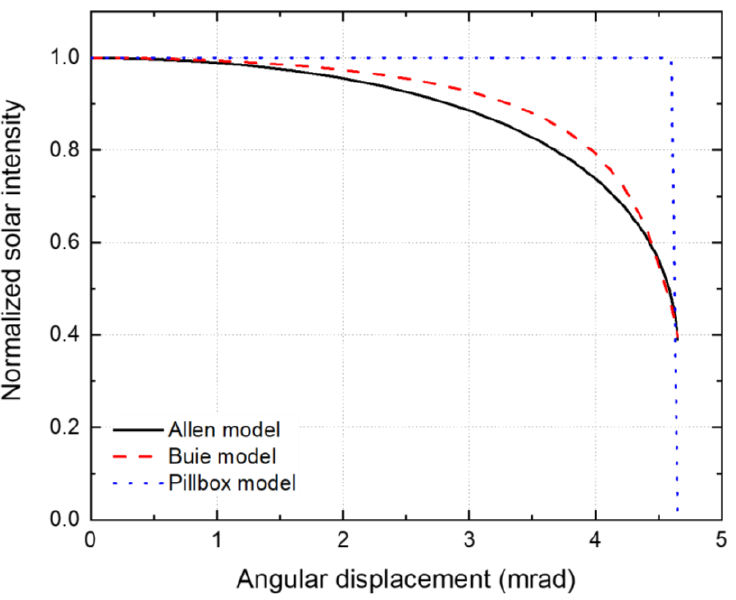
Figure 9. Solar limb-darkening